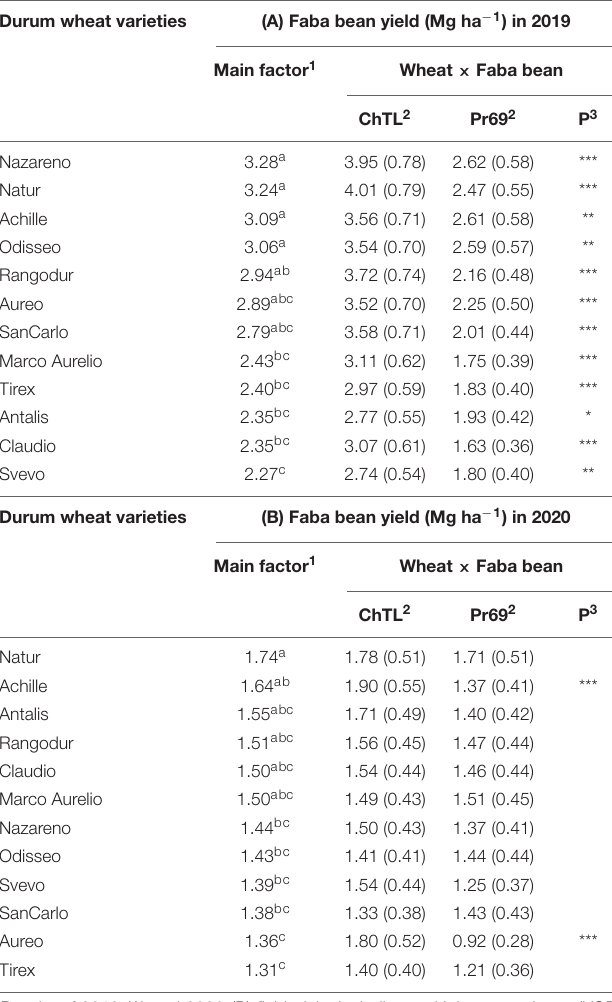
TABLE 2 | Faba bean yield (Mg ha − 1